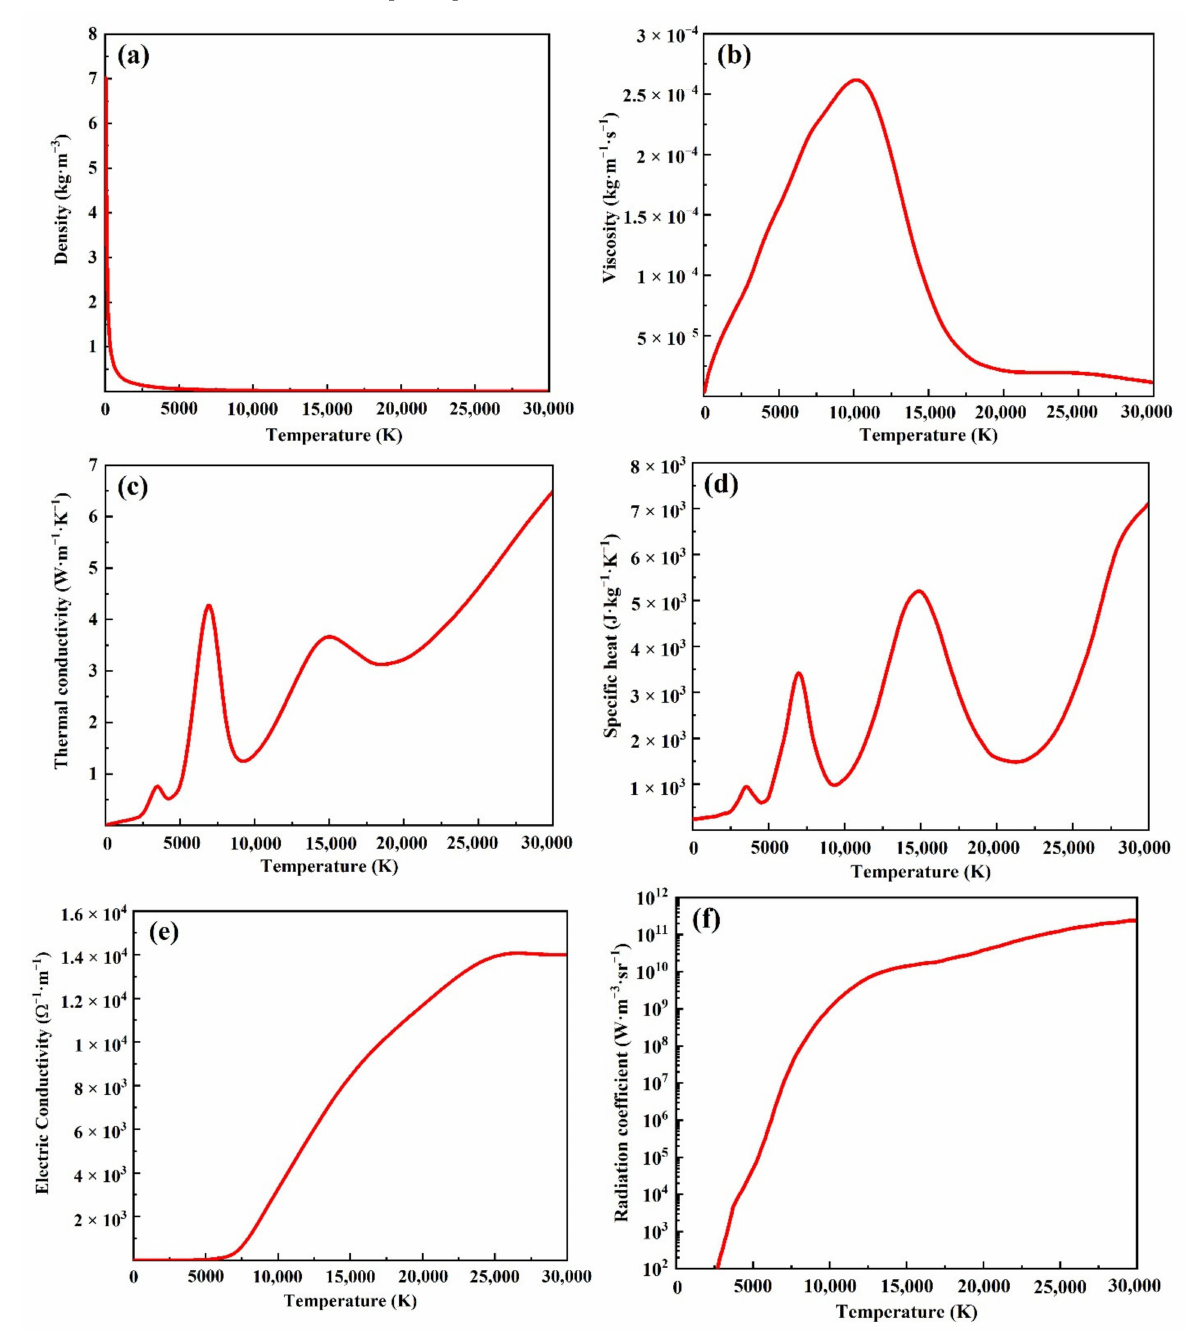
Figure 2. Thermodynamic and transport properties of the plasma arc: ( a ) density; ( b ) viscosity; ( c ) thermal conductivity; ( d ) specific heat; ( e ) electric conductivity; ( f ) radiation